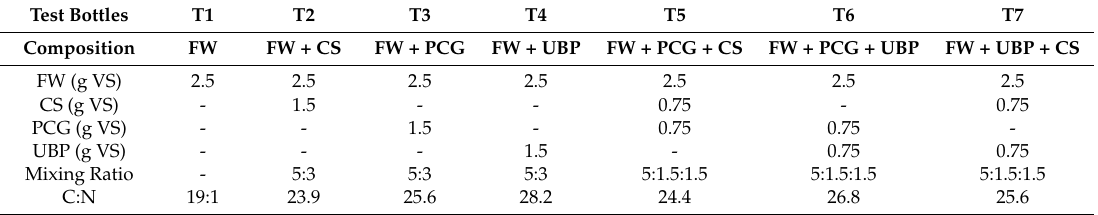
Table 3. The feedstock composition in batch tests (60 ◦ C) with codigestion